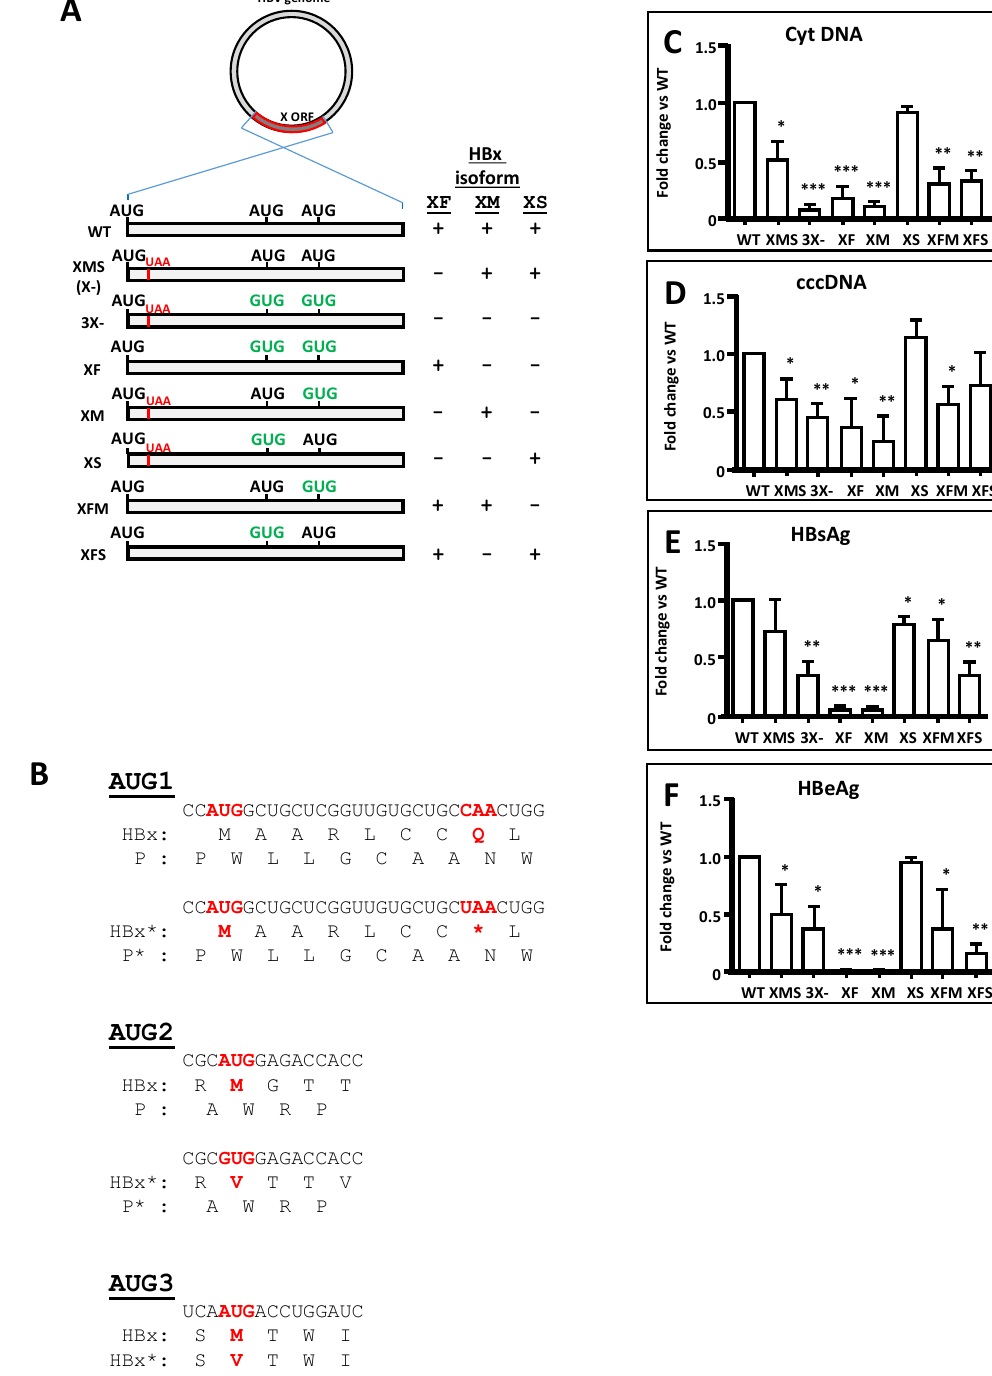
Figure 3. HBV DNA constructs for targeting the individual expression of the different HBx isoform proteins, and replication in HepG2 cells. ( A ) HBV DNA backbone containing HBx mutations of either individual HBx isoforms or all possible combinations of them [27,28]. To abolish the expression of HBx full-length (i.e., in the constructs XMS, 3X-, XM, XS) an early in-frame stop codon was introduced in the HBx reading frame. Additional point changes in the HBx reading frame are indicated by the GUG codon (green) replacing the corresponding AUG codon at either the second or third in-frame initiation codons. Protein expressions of each individual HBx isoforms for each HBV DNA construct are indicated in the columns to the right. ( B ) Point sequence changes on reading frames of either HBx or HBV P (polymerase) protein. Since the reading frames of HBx and P protein overlap but in a different phase (offset by one nucleotide), it is important that changes introduced into HBx reading frame do not affect HBV P protein. As shown, mutations in either AUG1 (top panel)